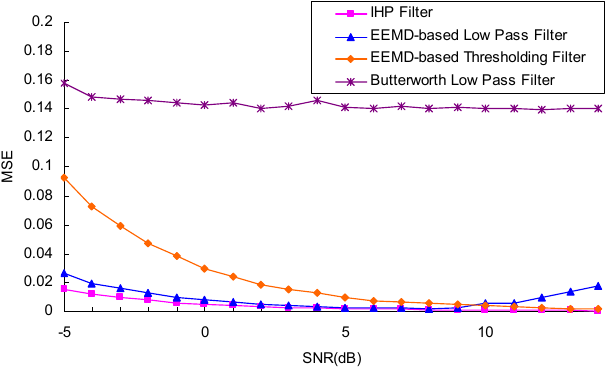
Figure 10. MSE obtained with different noise levels by proposed method, EEMD-based low pass filter and EEMD-based thresholding